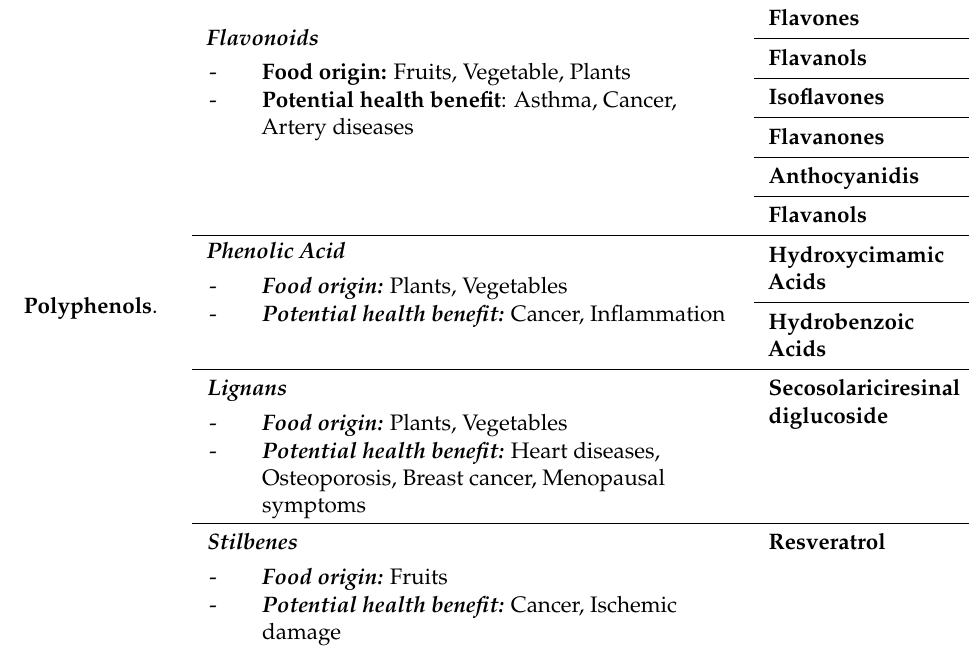
Table 2. Polyphenols classification, food origin, and potential health benefits.